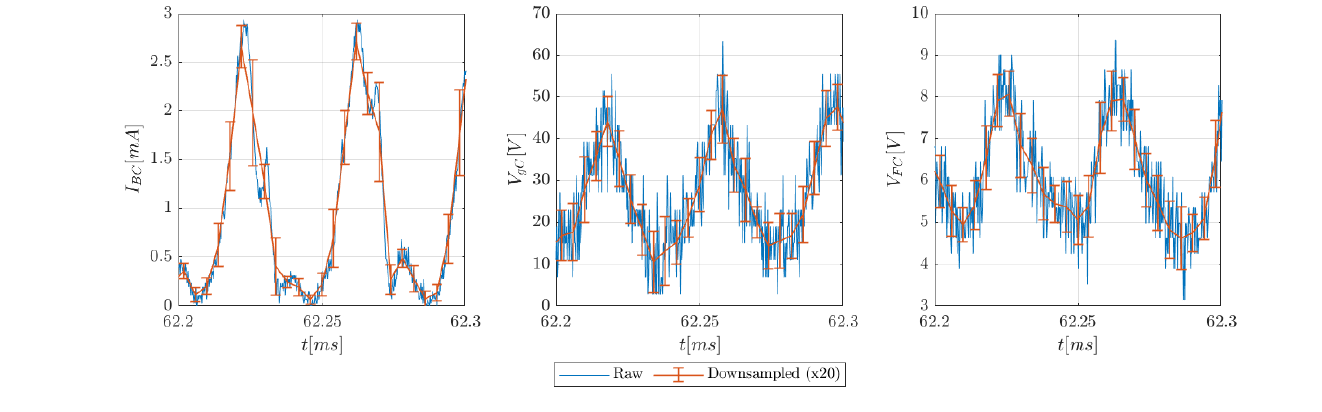
Figure 3. Example of triple Langmuir probe raw data and downsampled data.